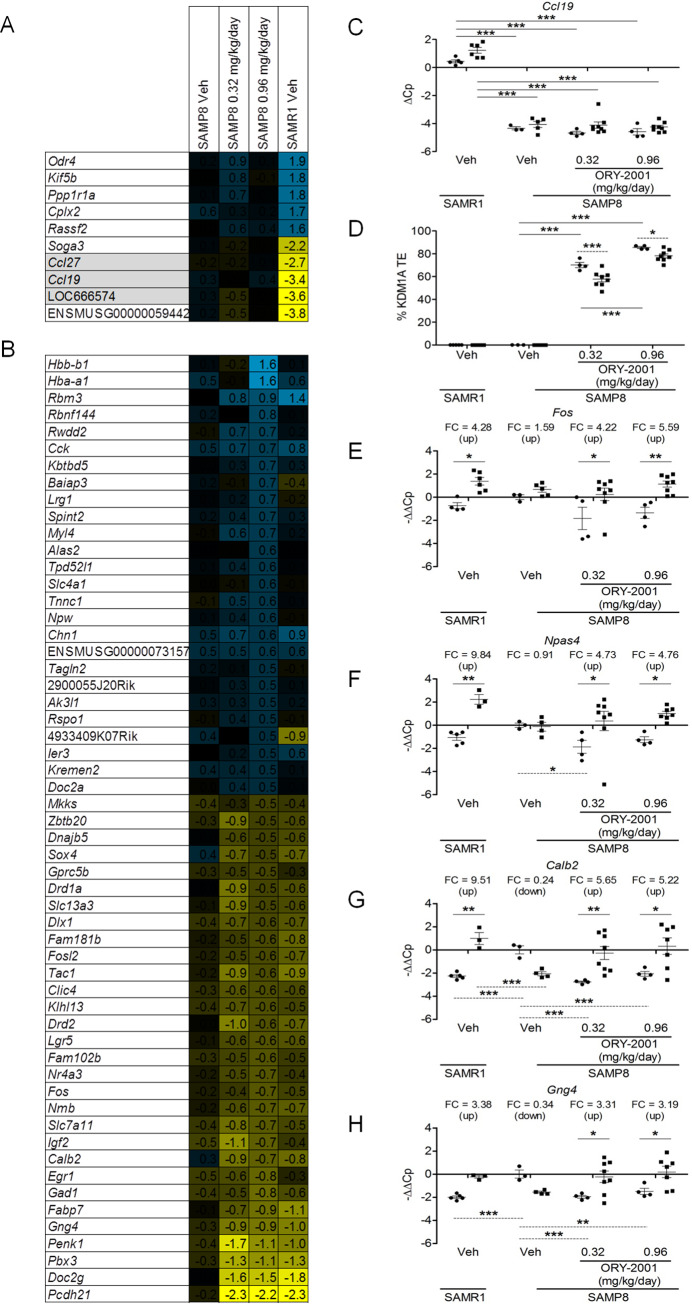
ORY-2001 restores the IEG stress response in the SAMP8 prefrontal cortex.Gene expression changes in SAMP8 mice: (A) Top 5 differentially regulated genes (up and down) in the PFC of SAMP8 vs SAMR1 mice in the basal condition identified by microarray survey. Ccl19, Ccl27 on chr4 amplified in SAMP8 compared to SAMR1 mice are genotype controls and highlighted in grey. (B) Microarray survey performed on PFC tissue of vehicle- and ORY-2001-treated mice shows that ORY-2001 partially restores the GE pattern seen in SAMP8 mice to SAMR1 controls. GE changes in basal conditions following treatment with ORY-2001 (genes with an expression change Log2 > 0.5 or Log2 < -0.5 (1.4 fold up or down) at the dose of 0.96 mg/kg/day in relation to vehicle-treated SAMP8 mice. Genes are ranked according to the highest expression change in the ORY-2001 0.96 mg/kg/day condition. All values represent Log2(Fold Change). The survey was performed on pooled samples from each experimental group (N = 3–5 mice per group). Veh = Vehicle. (C) qRT-PCR analysis of Ccl19 expression performed on cortex tissue was used to verify the genotype of individual mice. Dots: basal; squares: stress cohorts. Data were normalized by GusB and are plotted as ΔCp values. Graphs represent mean ± SEM. Solid line: one-way ANOVA analysis of basal and stress levels using Dunnett’s multiple comparison test relative to the vehicle-treated SAMR1 condition. ***p < 0.001.(D) KDM1A TE analysis used to verify the treatment group of individual mice. Dots: basal; squares: stress cohorts. Graphs represent mean ± SEM. Solid line: one-way ANOVA analysis of basal and stress levels using Tukey's multiple comparison test. Dotted line: two-way ANOVA with Bonferroni post-hoc analysis. *p < 0.05, ***p < 0.001. The effect of ORY-2001 treatment on the expression in the prefrontal cortex, following exposure to stress of (E) Fos (F3,34 = 1.128; p = 0.3514 Interaction), (F) Npas4 (F3,30 = 2.312; p = 0.0961), (G) Calb2 (F3,30 = 7.361; p = 0.0008) and (H) Gng4 (F3,30 = 5.648; p = 0.0034). Basal: N = 3–5 per group; RI test: N = 3–8 per group). Dots: basal; squares: stress cohorts. All qRT-PCR data are plotted as -ΔΔCp values relative to the basal vehicle-treated SAMP8 group. Fold changes (FC) were calculated as 2^[average(stress -ΔΔCp values)—average(basal -ΔΔCp values)]. Fos data were normalized by Gapdh; Npas4, Calb2 and Gng4 by GusB. Graphs represent mean ± SEM. Solid line: two-way ANOVA with Bonferroni post-hoc analysis. Dotted line: one-way ANOVA analysis of basal or stress levels using Dunnett’s multiple comparison test relative to the vehicle-treated SAMP8 condition. *p < 0.05, **p < 0.01, ***p < 0.001.